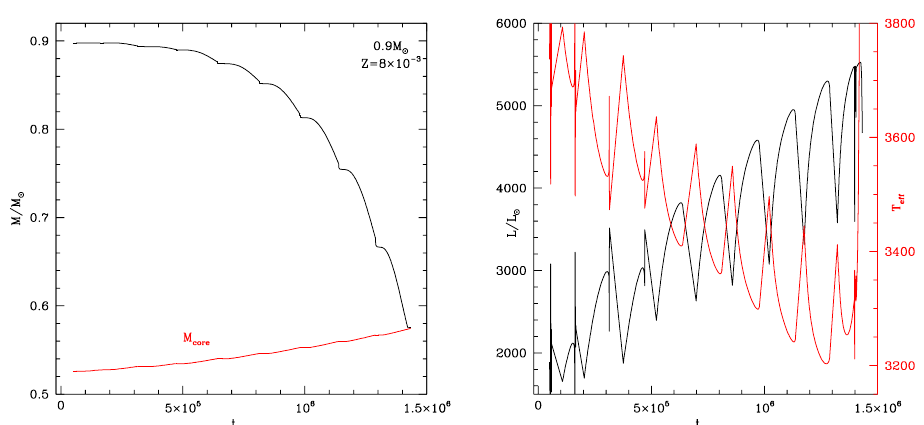
Figure 1. ( Left ) Variation during the AGB phase of the total mass (black line) and core mass (red) of a 0.9 M (cid:12) star of metallicity Z = 8 × 10 − 3 . ( Right ) variation of luminosity (black, scale on the left ) and effective temperature (red, scale on the right ) for the same model star in the left